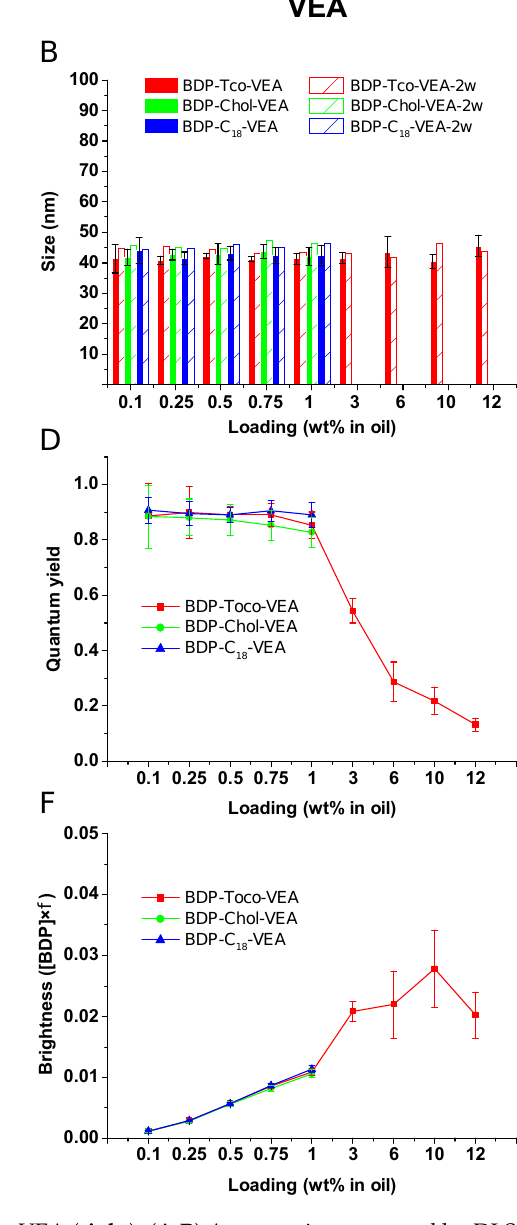
Figure 4. Properties of the BDP-loaded NEs in MCT ( left ) and in VEA ( right ). ( A , B ) Average size measured by DLS, solid bars are freshly prepared NEs and dashed bars are NEs after two weeks (indicated with the notation “ − 2w” in the insets). PDI averaged between 0.13 for MCT and 0.05 for VEA based NEs. Quantum yields of BDP-loaded NEs upon wt % increase ( C , D ) and their corresponding relative brightness ( E , F ), expressed as ϕ × [BDP] (unit: Molar), taking into account the molecular weight of the conjugates and regardless of the NEs’